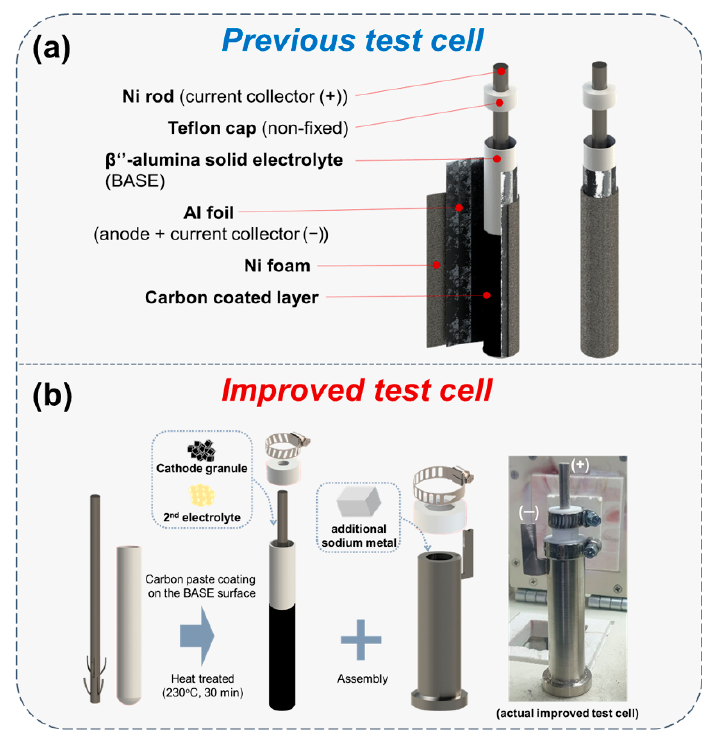
Figure 1. Schematic diagram of previous test cell and improved test cell. ( a ) Structure of previous test cell; ( b ) cell assembly process and photo of the actual improved test cell.